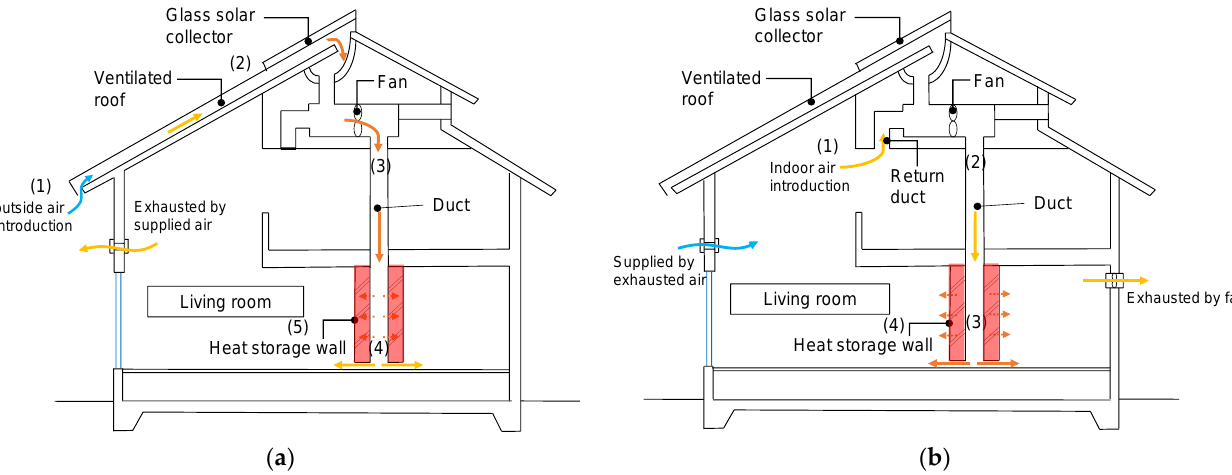
Table 1. Thermal properties of normal indoor wall (Type N) and indoor heat-storage wall (Types B and C).